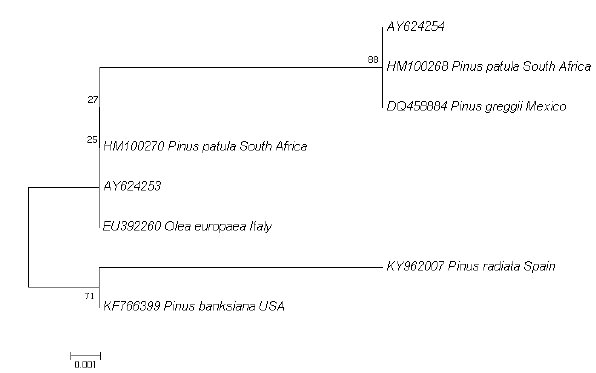
Figure 3. Dendrogram obtained from the dataset of eight Diplodia scrobiculata isolates using the EF1-α gene. Branch- es are labelled with bootstraps values. Unlabelled branch- es have bootstrap values less than